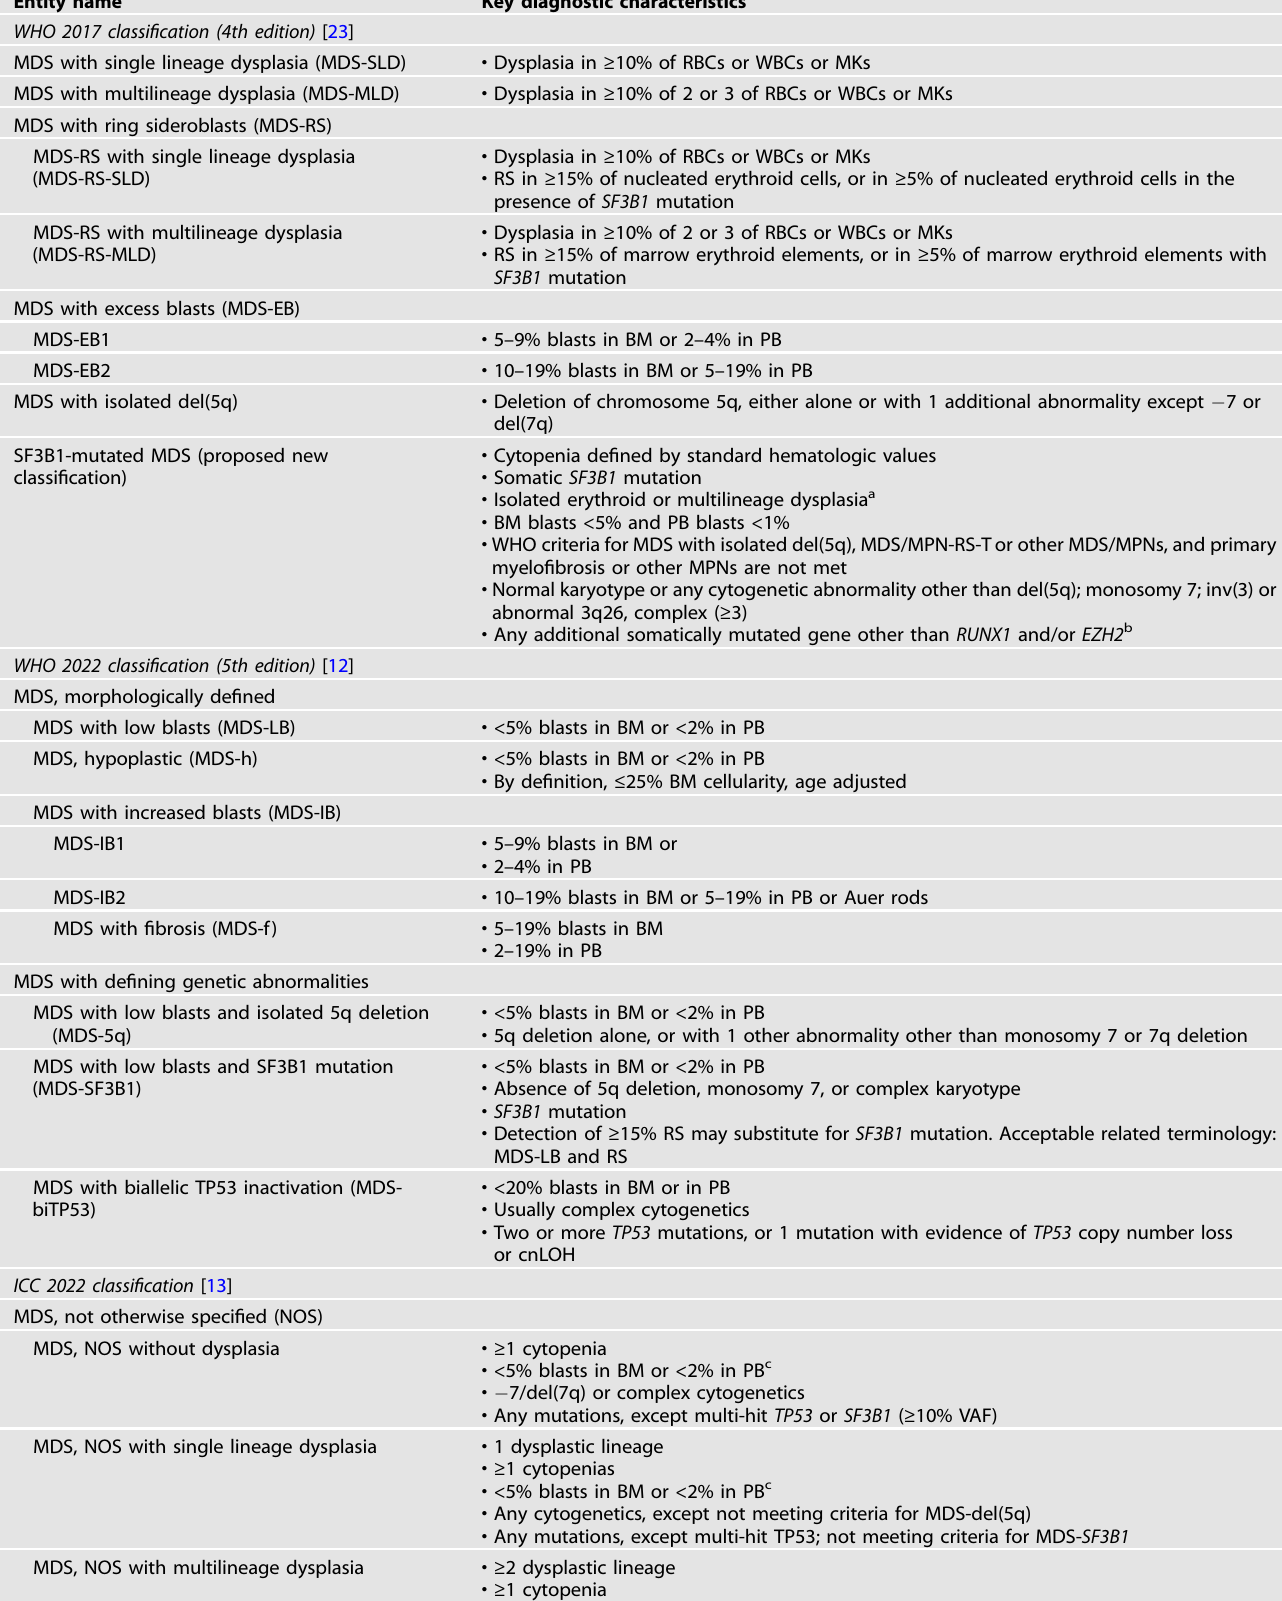
Table 1. Key classi fi cation criteria for MDS according to WHO 2017, WHO 2022, and ICC 2022. Entity name Key diagnostic